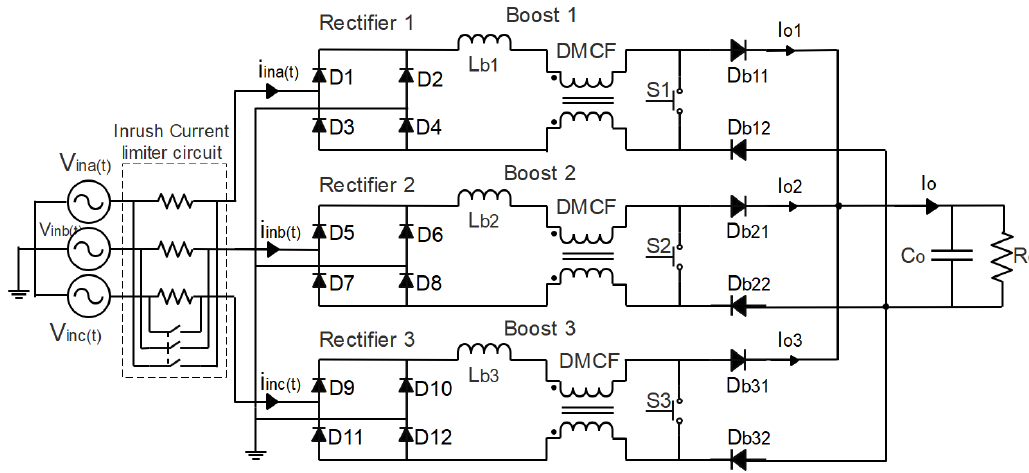
Figure 2. Proposal of three-phase modular rectifier.